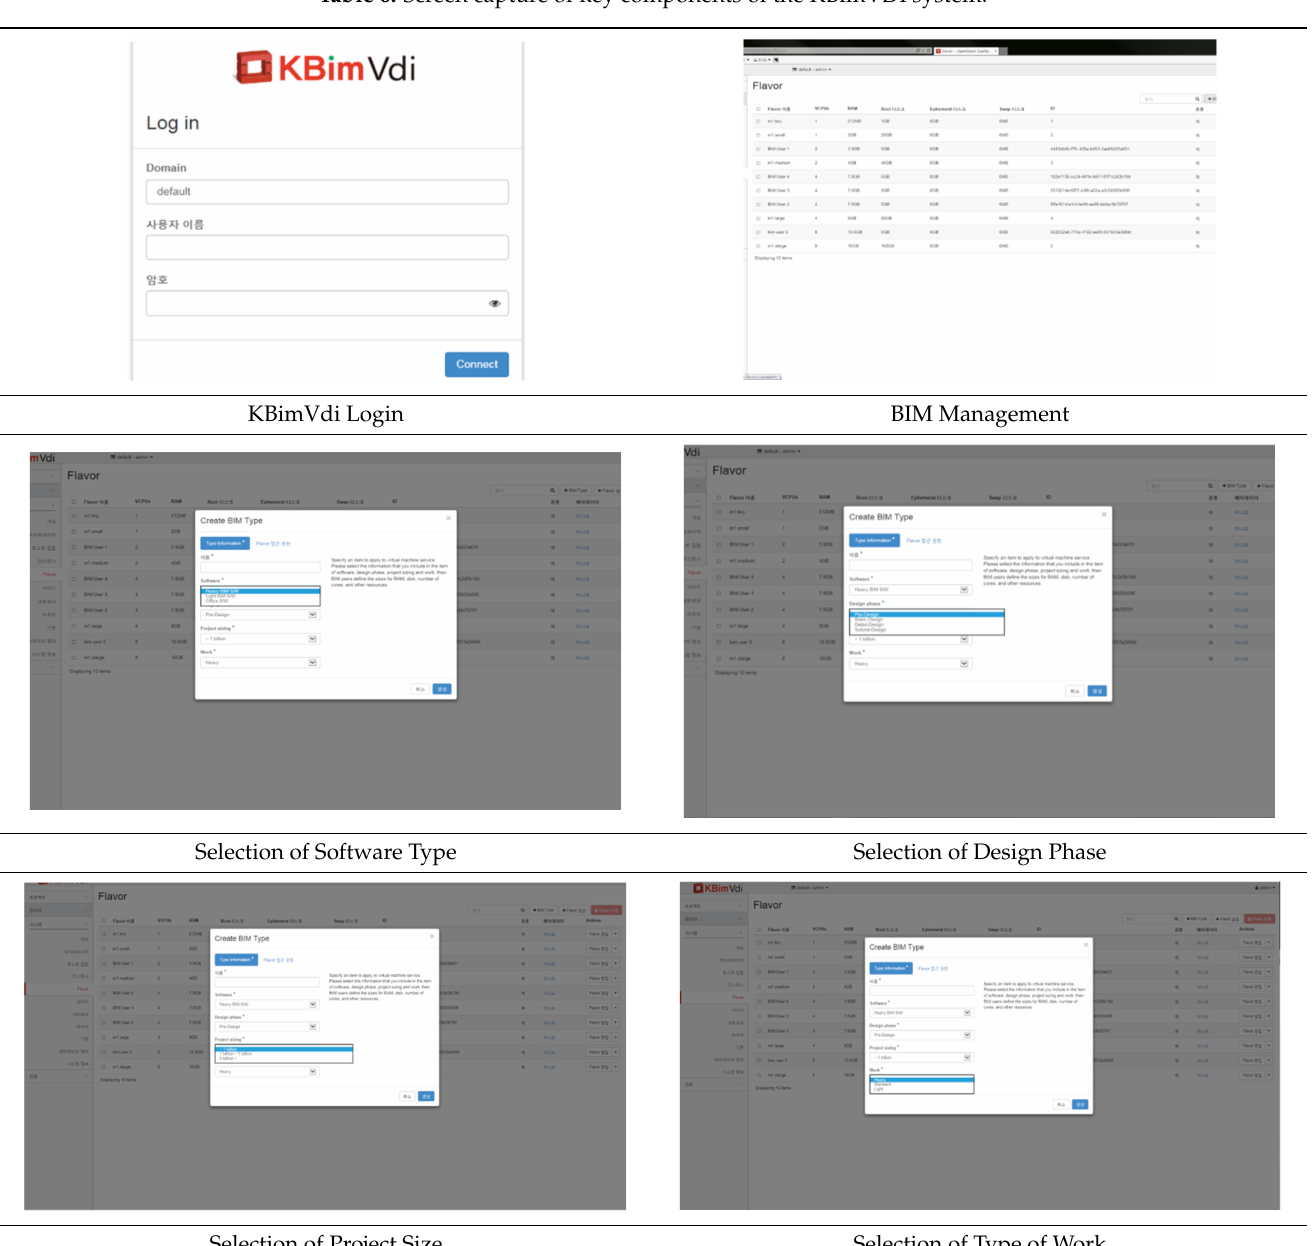
Table 6. Screen capture of key components of the KBimVDI